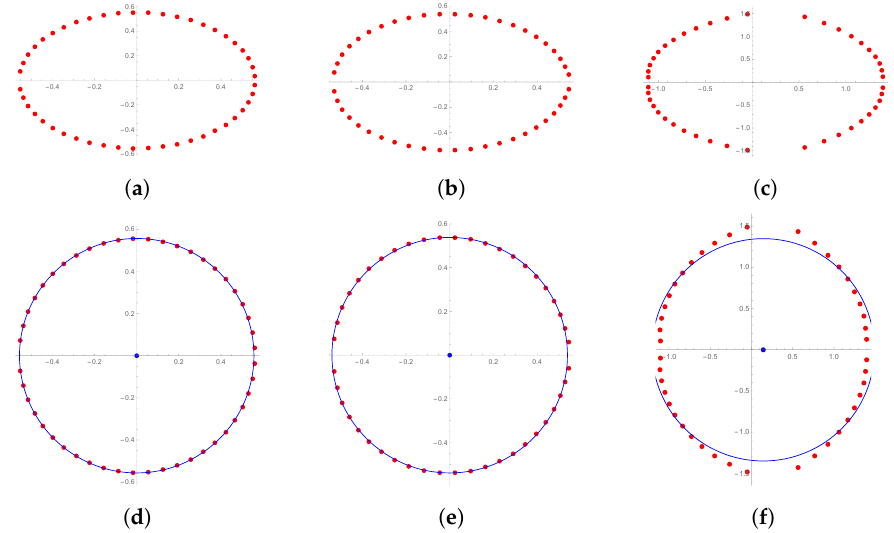
Figure 3. Approximate roots and approximate circle of B n , q ( x ) for n = 50. ( a ) q = 0.1; ( b ) q = 0.5; ( c ) q = 0.9; ( d ) q = 0.1; ( e ) q = 0.5; ( f ) q = 0.9. Table 3. The circle of approximate roots of B 50, q ( x ) . Center ( x , y ) Radius Error Range q = 0.1 ( 0.00144168, − 8.79432 × 10 − 14 )